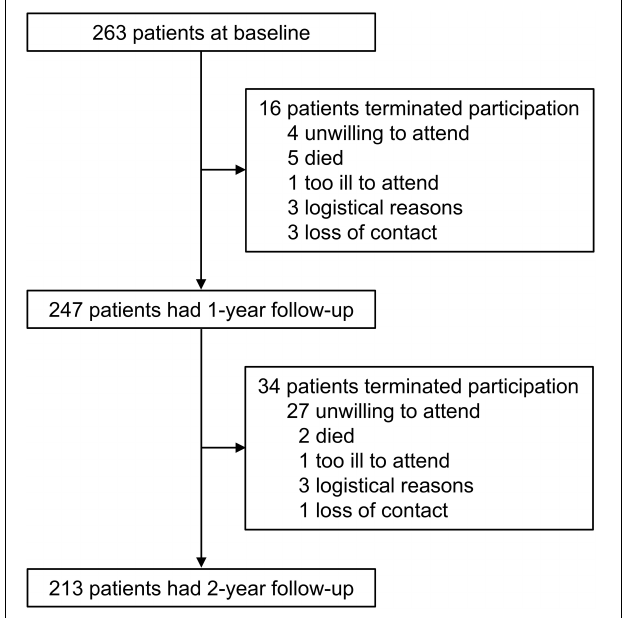
FIGURE 1 | Study profile. Data show the patient number at each visit and the reasons for the dropout.